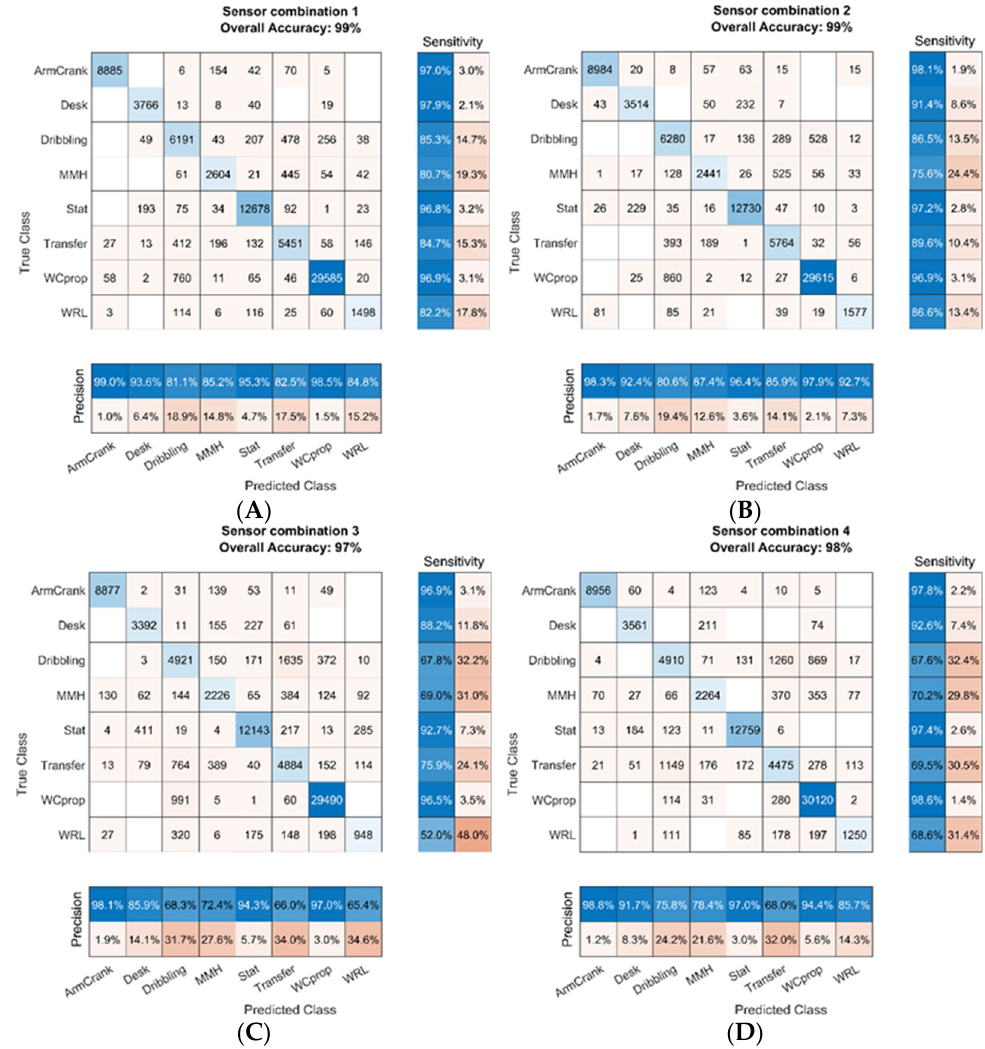
Figure 4. The confusion charts for the four sensor combinations, ( A ) = combination 1, ( B ) = combination 2, ( C ) = combination 3, ( D ) = combination 4.